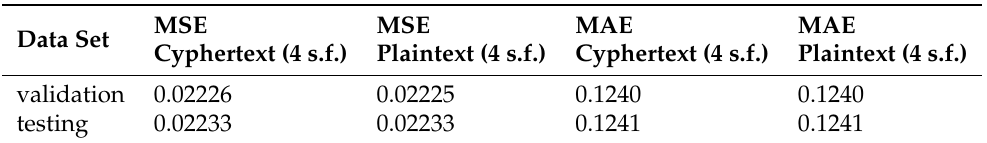
Table 3. Output of loss functions for both validation and testing sets, using Mean Squared Error (MSE), and Mean Absolute Error (MAE) when using our neural network from Figure 4. Data Set